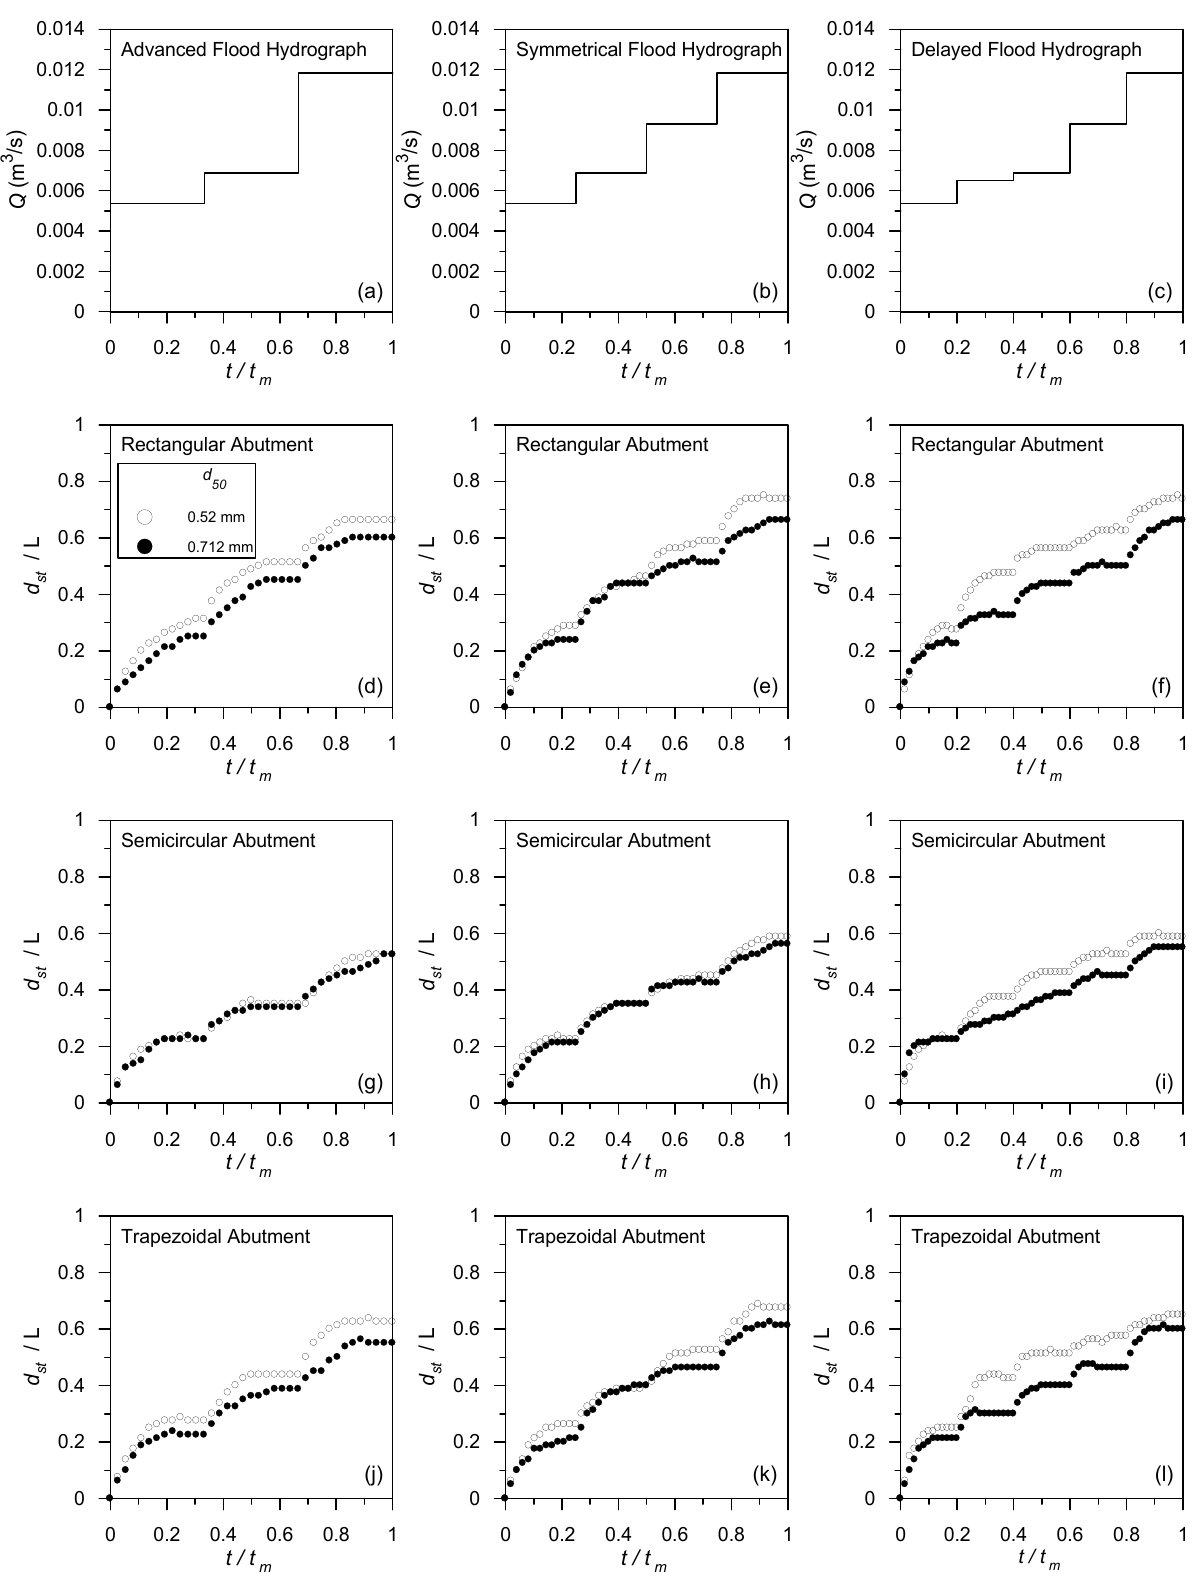
Figure 3. Comparison of temporal variation of non-dimensional scour depth d st / L for different sediment sizes and hydrographs.